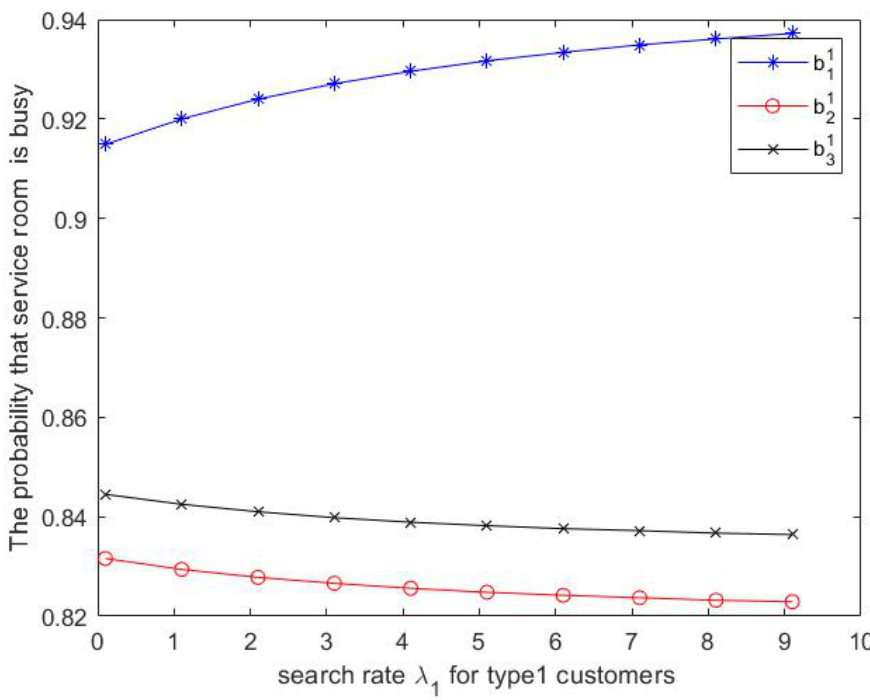
Figure 7. Effect of λ 1 on probability that the service room is